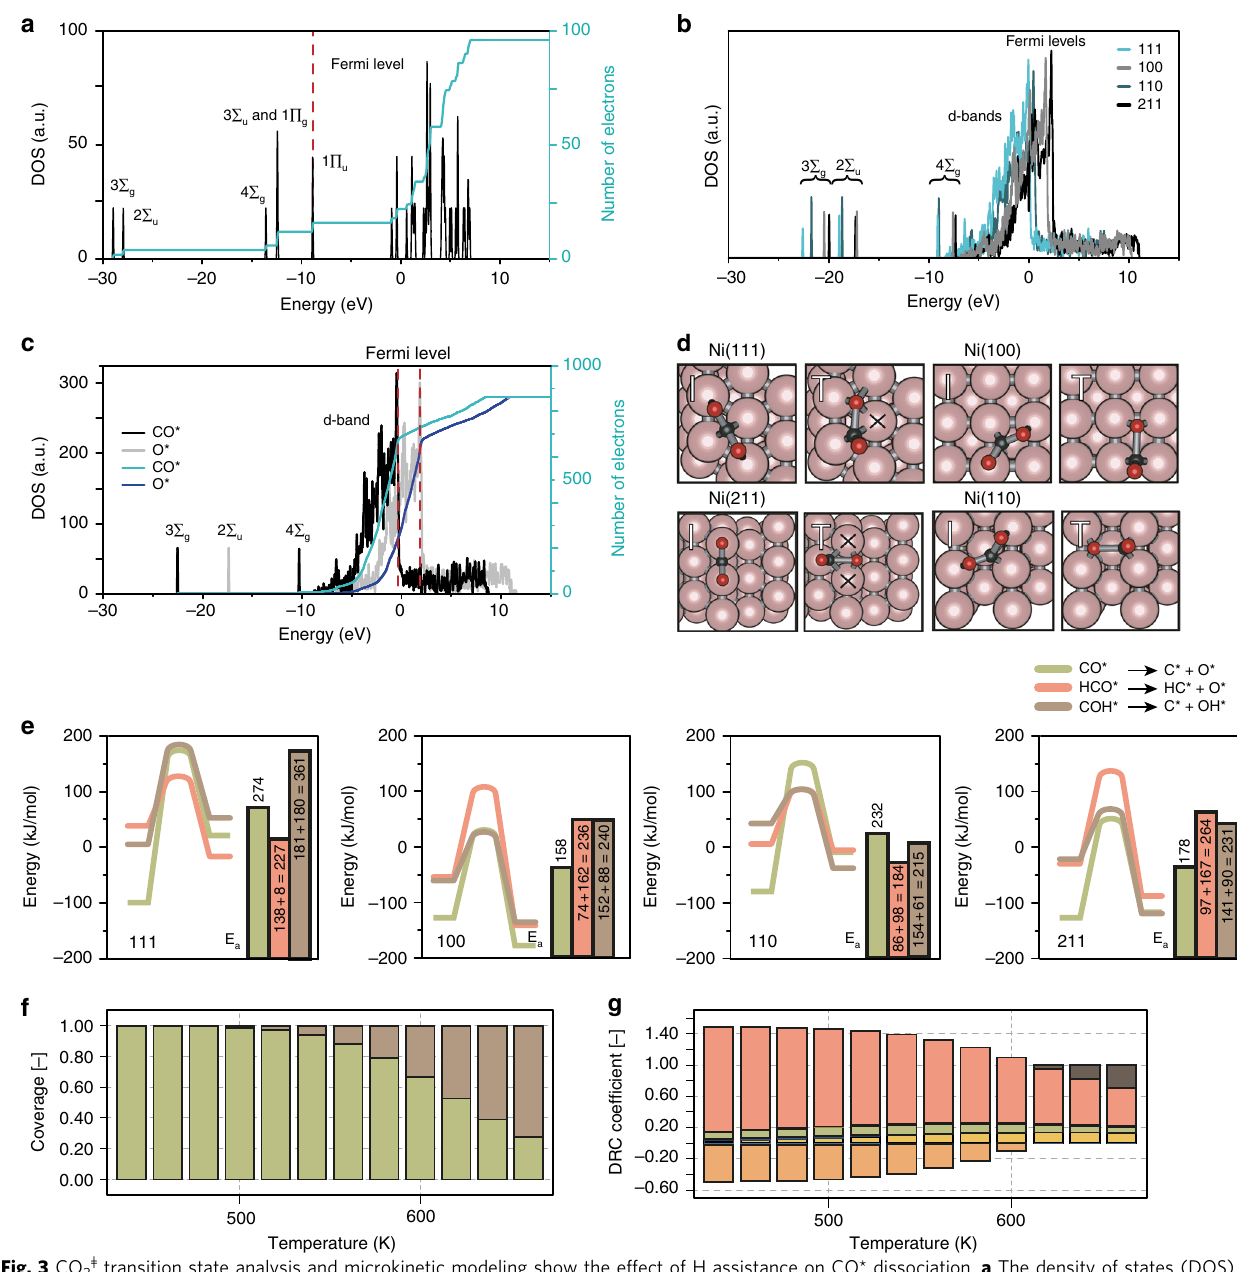
Fig. 3 CO 2 ǂ transition state analysis and microkinetic modeling show the effect of H assistance on CO* dissociation. a The density of states (DOS) and integrated DOS of CO 2(g) . Each peak corresponds to a molecular orbital. b DOS analysis of transition state CO 2 ǂ in CO 2 * → CO* + O* on Ni(111), Ni(100), Ni(110), and Ni(211). c DOS of the fi nal state of CO 2 * → CO* + O* on Ni(100). d Geometries of CO 2 on four nickel facets in the initial and transition state for direct CO 2 dissociation on the four Ni facets. Shared atoms are indicated by a cross. e Energy barriers of (H-assisted) CO dissociation on Ni(111), Ni (100), Ni(110), and Ni(211). f , g Microkinetic modeling of individual reaction steps on the Ni(110) surface in a temperature range from 440 to 660 K. f Coverage as a function of temperature (green, CO; gray, empty adsorption site*) g degree of rate control (DRC) coef fi cients (red, HCO* + * ↔ CH* + O*; green, COH* + * ↔ CO* + H*; orange, OH* + H* ↔ H 2 O* + *; yellow, CH 2 * + H* ↔ CH 3 + *; gray, CO 2 * + H* ↔ COOH* +